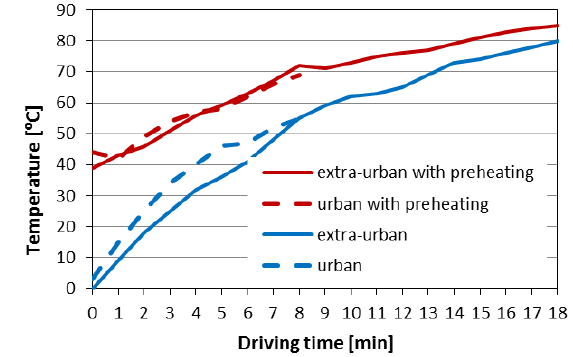
Fig. 8. Increase in engine temperature of the vehicle on the test track “urban” and “extra urban” as a function of driving time with and without engine preheating